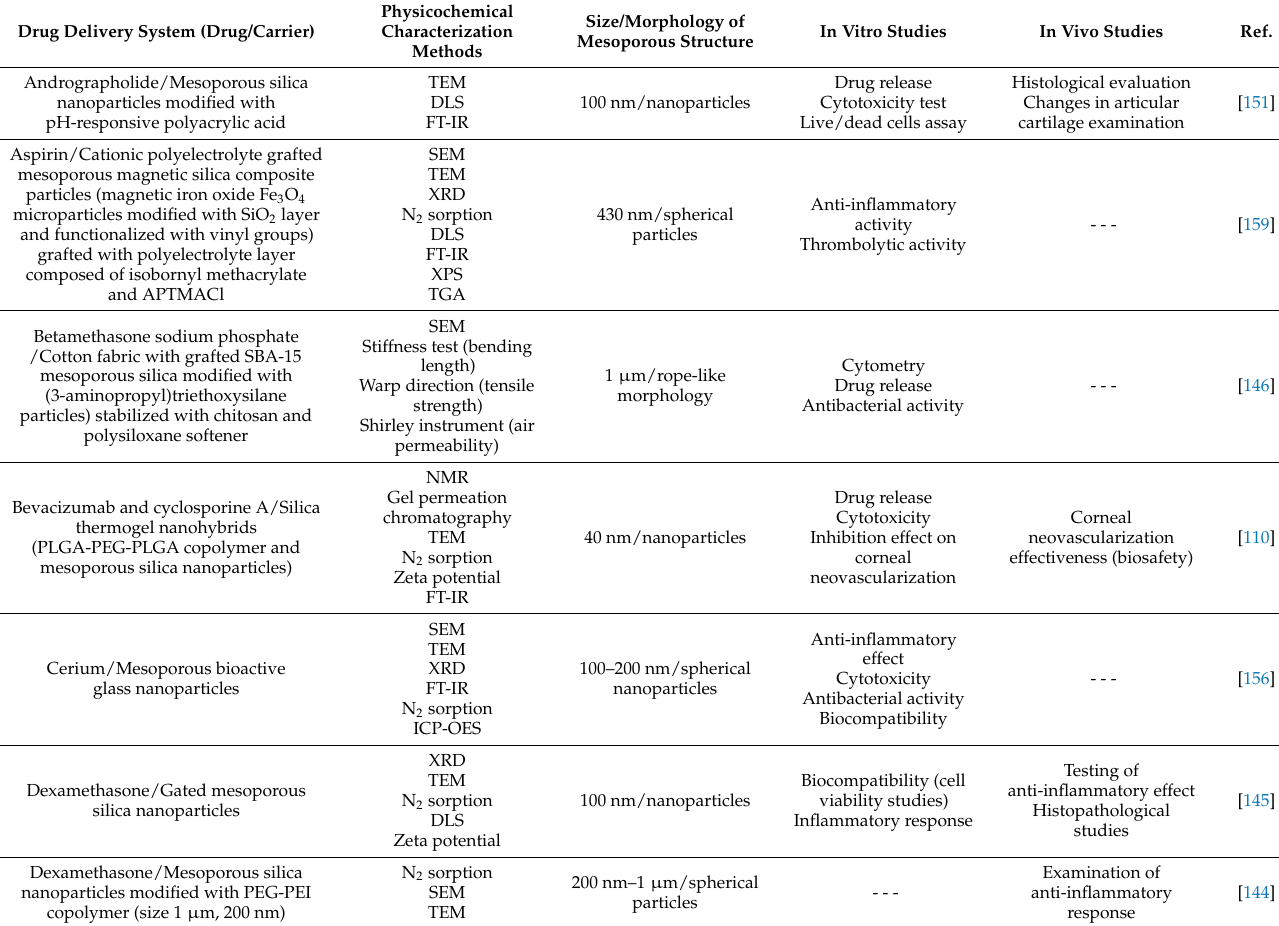
Table 3. Physicochemical and biological characterization methods of mesoporous material-based drug delivery